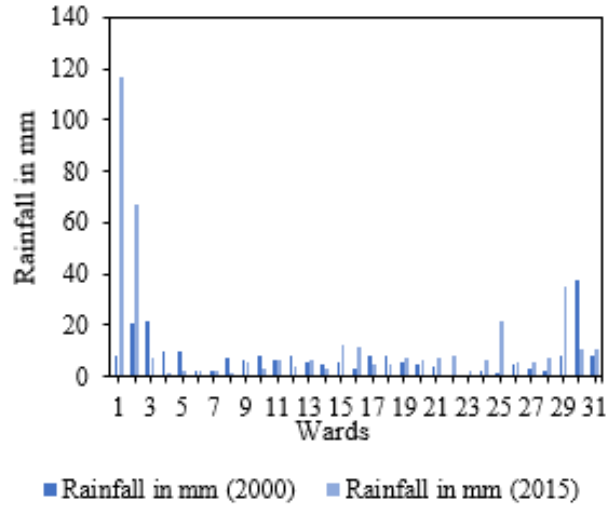
Figure 5. Daily rainfall situation (July 2000 and 2015).